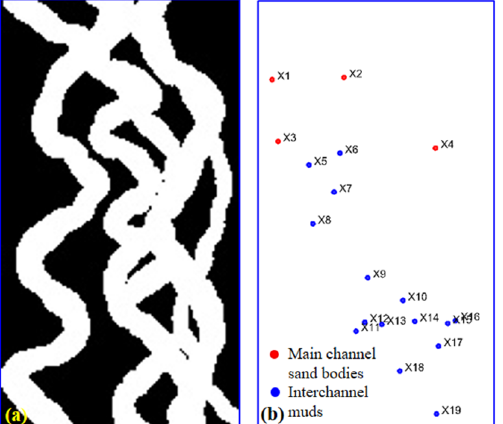
Figure 15. Training images and well point hard data of facies modeling of NG1 layer in X area of Shengli Oilfield. ( a ) Training images ( b ) well point hard data.